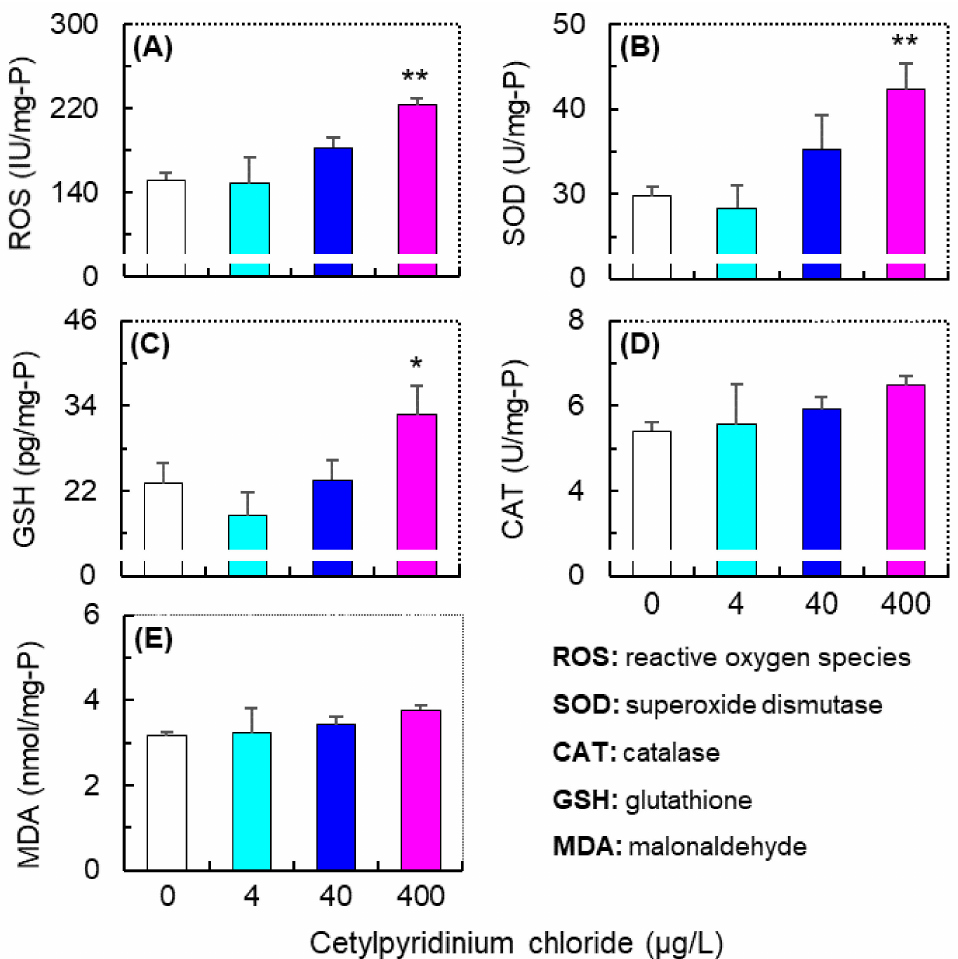
Figure 4. Variations in the levels of ROS ( A ), SOD ( B ), GSH ( C ), CAT ( D ) and MDA ( E ) in zebrafish larvae exposed to cetylpyridinium chloride at levels of 0 (control), 4.0, 40, and 400 µ g/L for 120 h post-fertilization (hpf). Data are shown as mean ± SE ( n = 3) and asterisks denote statistically significant differences between the exposure and control groups (* p < 0.05; ** p <